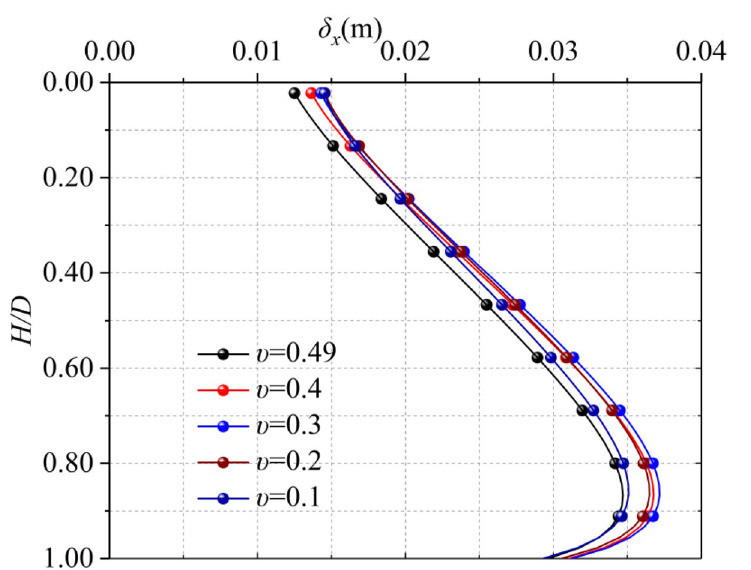
Figure 7. Horizontal displacement of different Poisson’s ratio